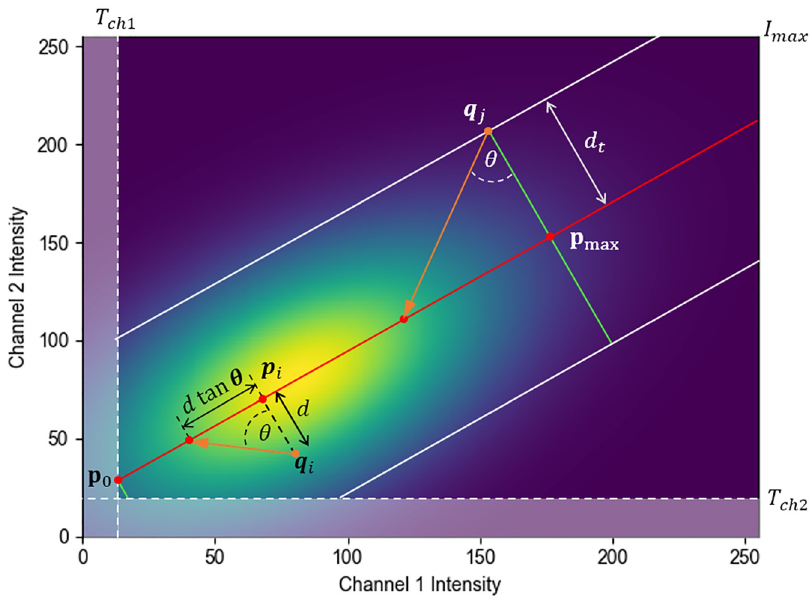
Fig 4. Illustration of the effect of the colourmap thresholds using a synthetically generated scatter plot, where the colourmap brightness indicates the frequency of voxels with a given colocalisation intensity. The regression line is shown in red, with two example intensity pairs, q and q , shown in orange. A penalization factor θ is applied when i j projecting both q i and q j onto the regression line. Only the sample data above the channel thresholds, T ch 1 and T ch 2 , are considered when determining the distance threshold d , shown in white. Any colocalisation intensities q beyond the t i maximum point p max are assigned a colourmap value of 1. Similarly any q i below the minimum point p 0 are assigned a colourmap value of 0. These thresholds are indicated with two green lines at the respective points. Both d and p max are t determined independently to include 99% of the data, thereby excluding outliers from the visualisation. The final colourmap value C i varies linearly between 0 to 1 from p 0 to p max